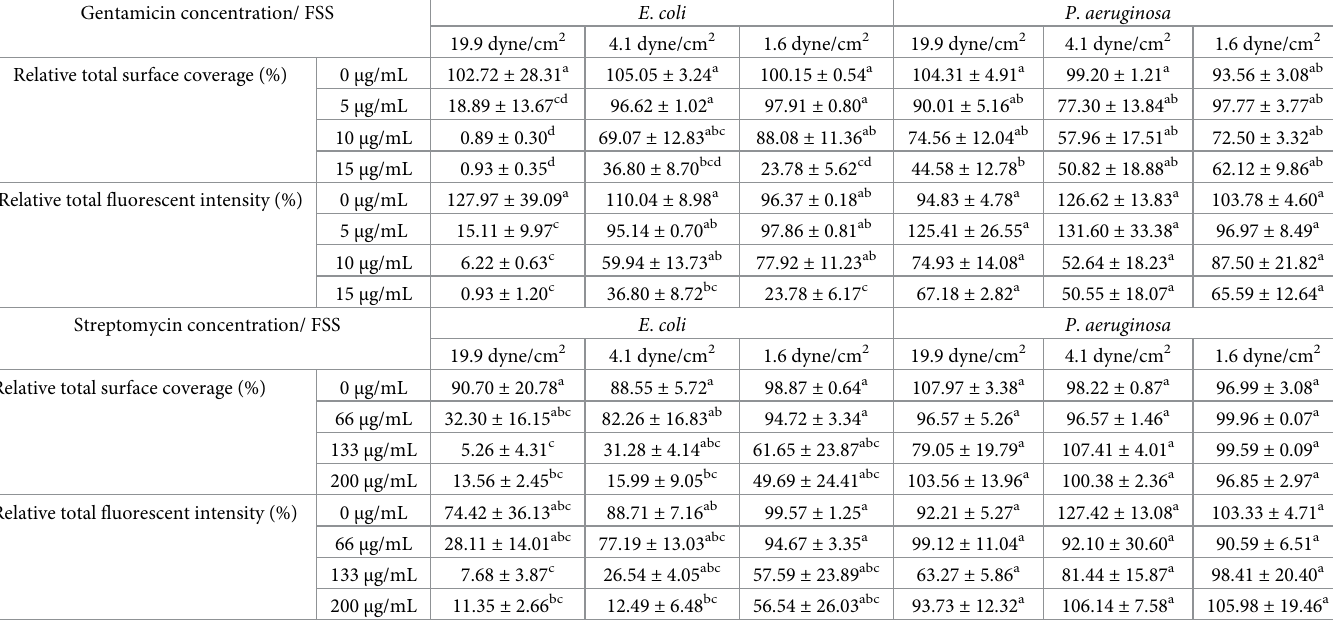
Data represent the mean of three replicates, reported as the percentage normalized with the initial time point (T 0 ) of each treatment. Values are expressed as means ± SEM, n = 3. a, b, c, d indicate significant differences within the relative surface coverage (%) or total fluorescence intensity (%) each bacteria/antibiotic treatment group with all the FSS levels p <